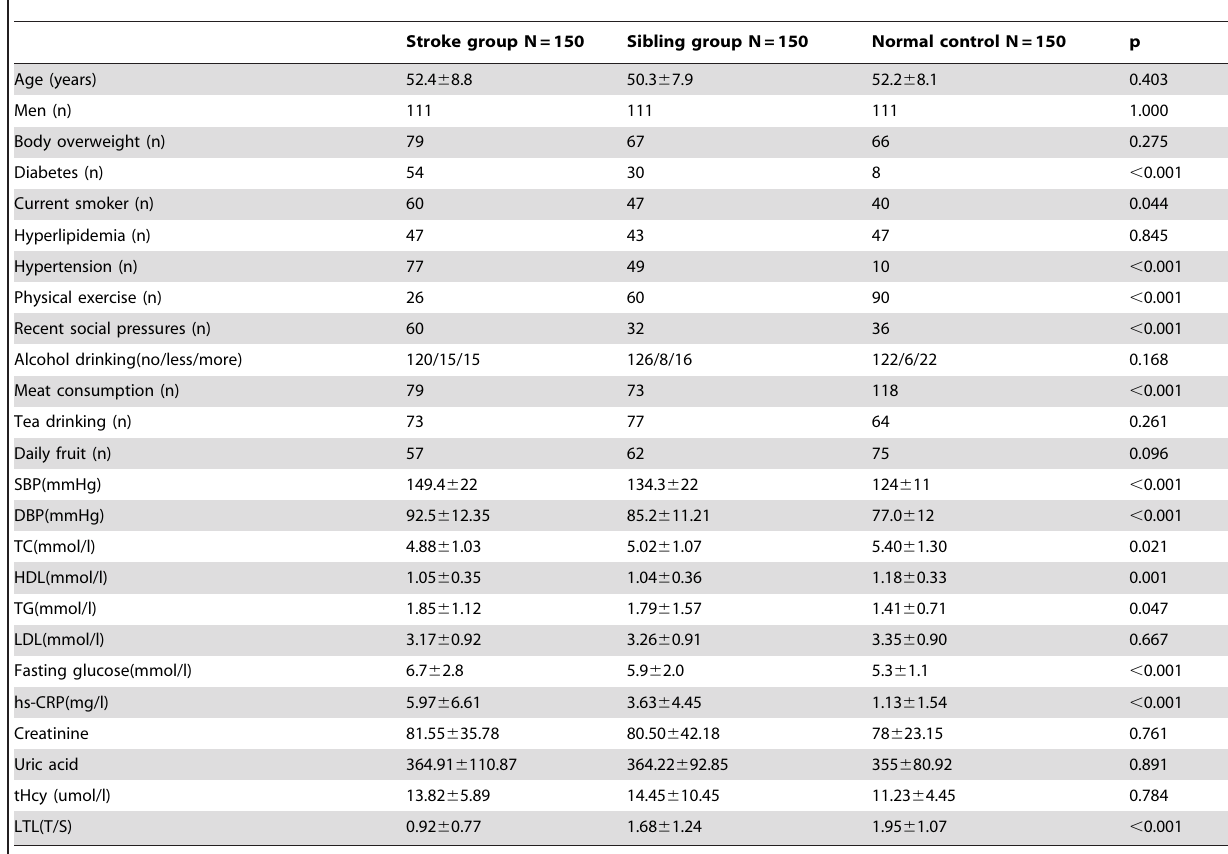
Table 1. Characteristics of study subjects in different